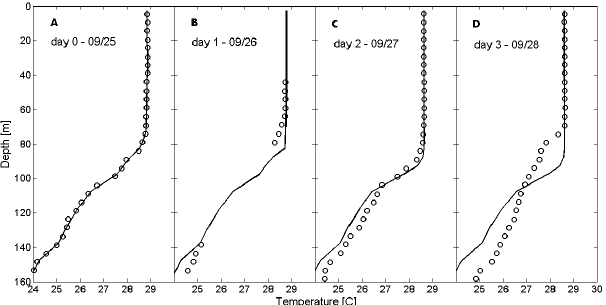
Figure 10. Comparison between Argo profile temperature obser- vations (circles) and the 3DPWP model with the typhoon Hagupit Fig. 10. Comparison between Argo profile temperature observations (circles) and the 3DPWP 3 setup (black solid line). Four plots are presented (A–D) showing a model with the typhoon Hagupit set up (black solid line). Four plots are presented (A-D) 4 comparison between 19 September (A) and 22 September (D) . showing a comparison between September 19 (A) and September 22 (D). 5